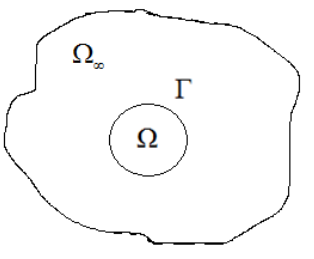
Fig. 1. Representative volume of